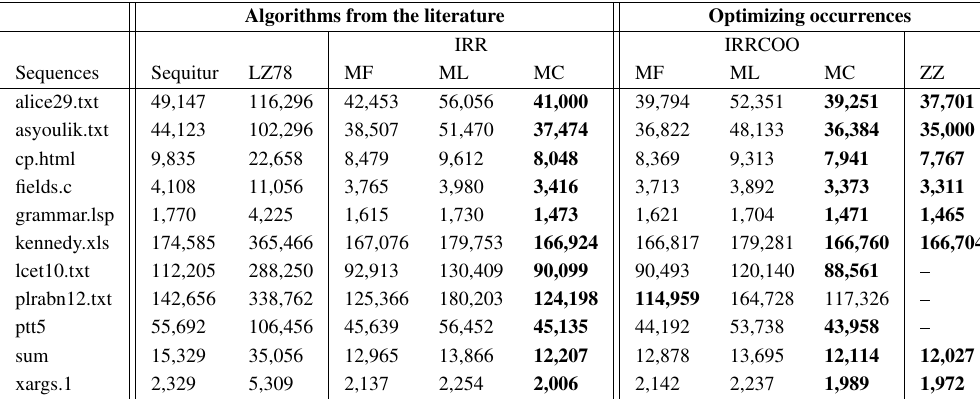
Table 2. Grammar sizes on the Canterbury corpus. The files over which ZZ did not finished are marked with a